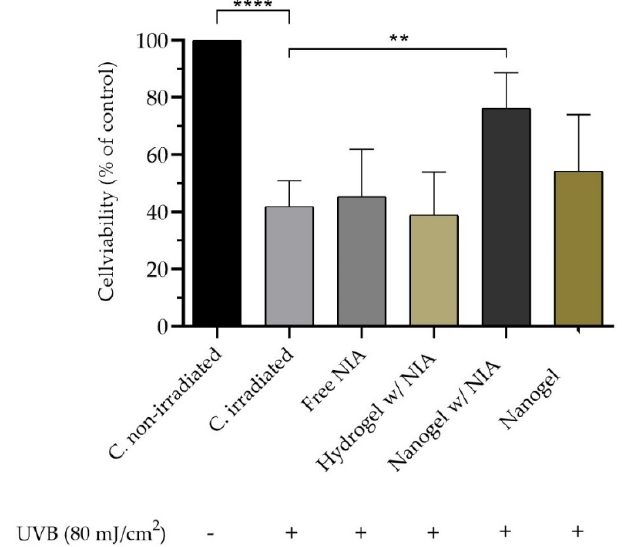
Figure 6. Effects of free NIA and NIA-loaded hydrogel and nanogels on cell viability in UVB (80 mJ/cm 2 ) irradiated HaCaT keratinocytes at a concentration of 100 μ M. Data are representative of five independent experiments as mean ± SD. Symbol – represents “absence of” while + means “exposure to”. Asterisks indicate statistical significance (*, p ≤ 0.05; **, p ≤ 0.01; ***, p ≤ 0.001; ****, p ≤ 0.0001). No asterisks indicate no statistical significance ( p > 0.05).